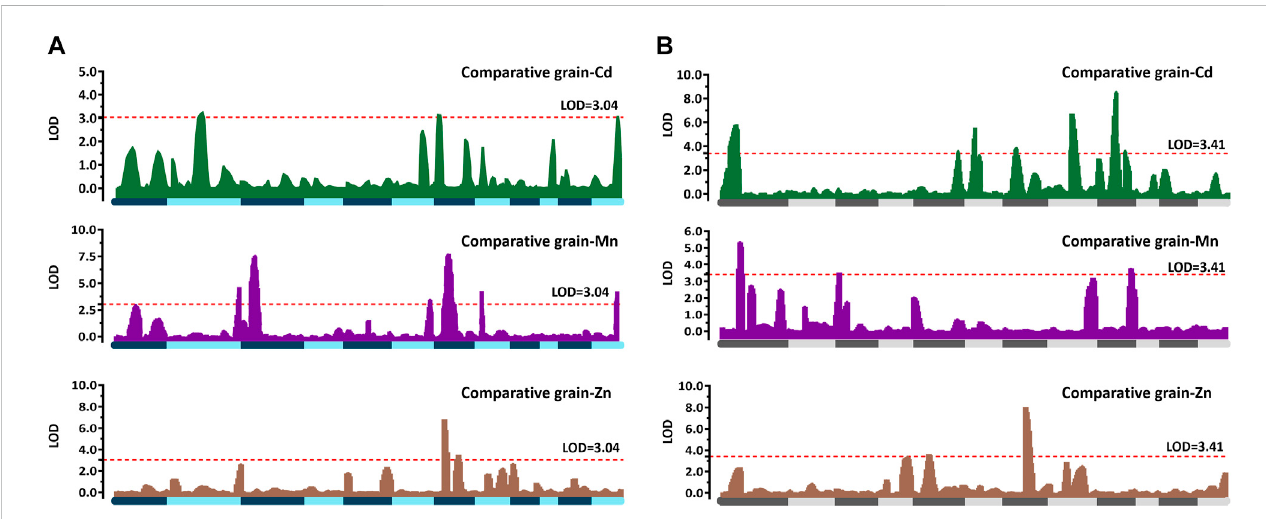
FIGURE 3 QTL identi fi cations responsible for the variations in CCd, CMn, and CZn the two RIL populations. The horizontal axes represent the 12 chromosomes assembled in order, and all the detected QTLs are mapped to the respective positions. The regions in green, purple, and brown indicate the QTLs detected basedonphenotypicvariationsusingthecomparativegrain-Cd,grain-Mn,andgrain-ZnlevelsinPop6-RIL (A) andPop15-RIL (B) .Thedottedredlinesindicate the threshold LOD score of 3.04 in Pop6-RIL, and 3.41 in Pop15-RILs determined using permutation test with 1,000